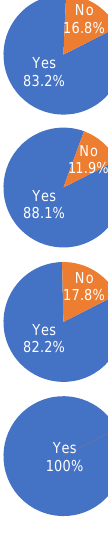
Figure 4. General practitioners’ (n = 12) responses to the patient-interaction questionnaire for 185 patients. NHS, National Health Service; PHE, Public Health England. GPs reported vaccinating 137 of 185 patient participants (74.1%) with aTIV during